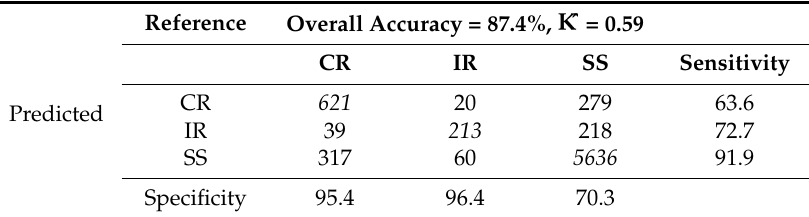
Table 4. Error matrix for BC2. Class codes as follows: Infralittoral rock and other hard substrata (IR); Circalittoral rock and other hard substrata (CR); Sublittoral sediment (SS). Italicized values indicate correctly classified observations.